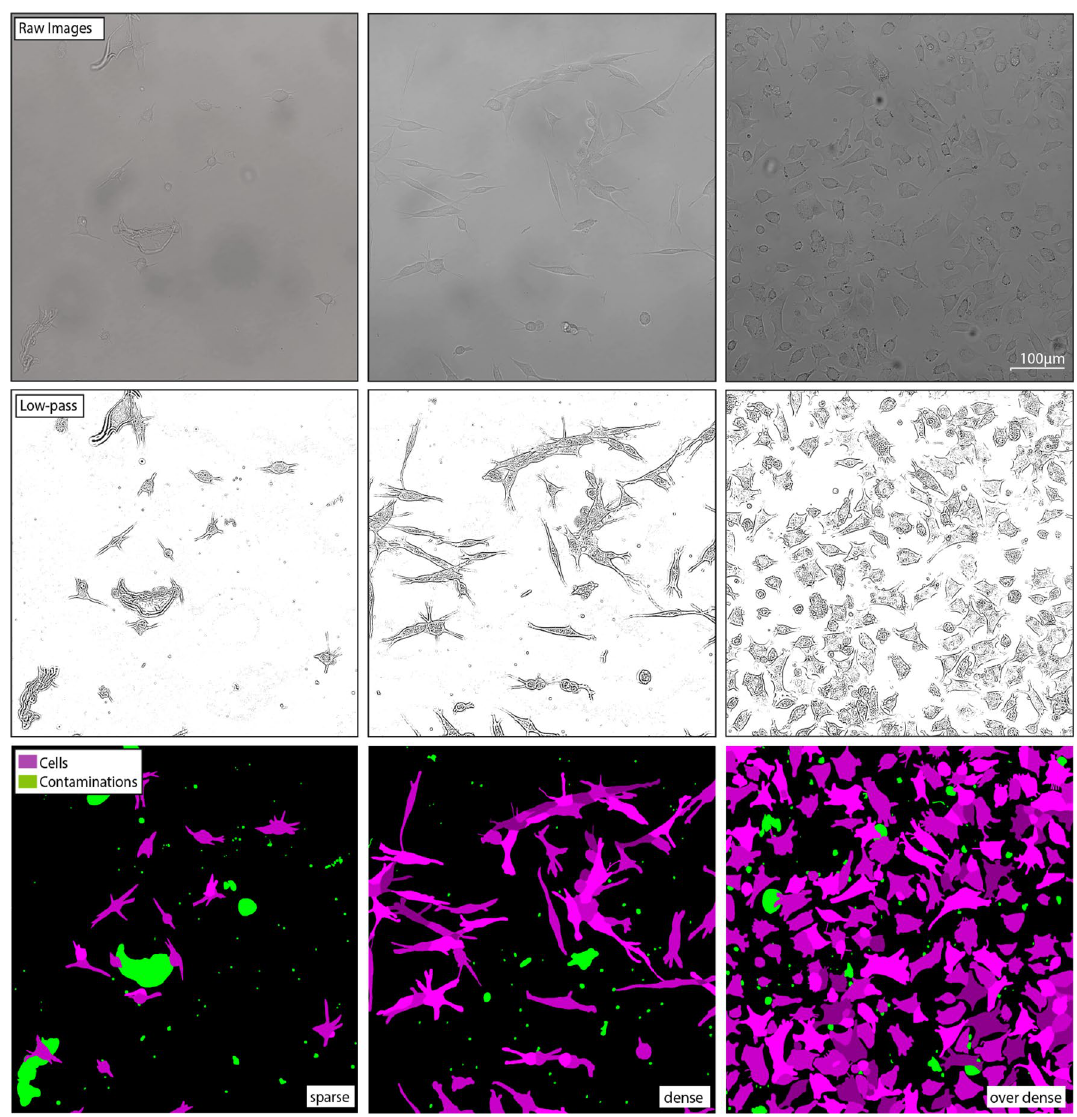
Figure 3. Annotation examples annotations of microscopic images for varying object densities (from left to right). The different colors represent cells - shades of purple, contaminants - green and background -